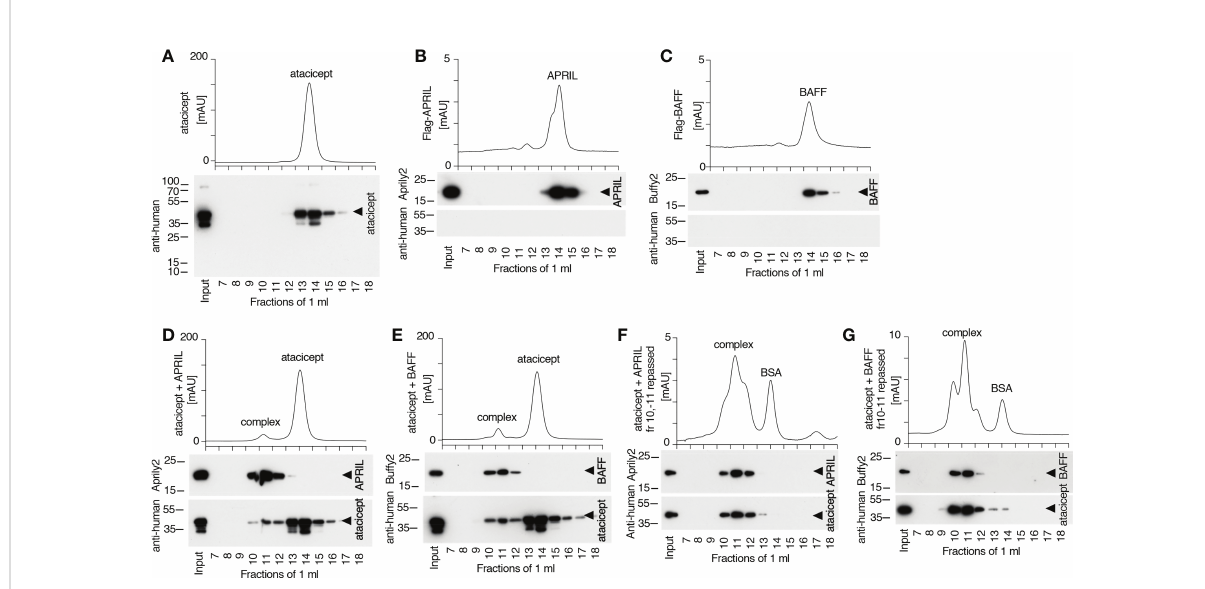
FIGURE 9 Size and stability of BAFF, APRIL, atacicept and complexes thereof. Size exclusion chromatography pro fi les of atacicept, Flag-BAFF and Flag-APRIL using PBS 10 m g/ml bovine serum albumin as elution buffer. Fractions were analyzed by Western blot using anti-human IgG antibody (to detect atacicept), anti-APRIL mAb Aprily2 and/or anti-BAFF mAb Buffy2, as needed. (A) Atacicept (200 µg). (B) Flag-APRIL (10 µg). (C) Flag-BAFF (10 µg). (D) Atacicept (200 µg) mixed with Flag-APRIL (10 µg). (E) Atacicept (200 µg) mixed with Flag-BAFF (10 µg). (F) APRIL/atacicept complex from fractions 10 and 11 of panel (D) were concentrated and analyzed again by size exclusion chromatography. The peak labelled “ BSA ” corresponds to bovine serum albumin of the elution buffer that had been co-concentrated with the complex. (G) Same as panel F, but for the BAFF/atacicept complex. Experiment was performed once in this format (twice for atacicept alone, atacicept plus BAFF and atacicept plus